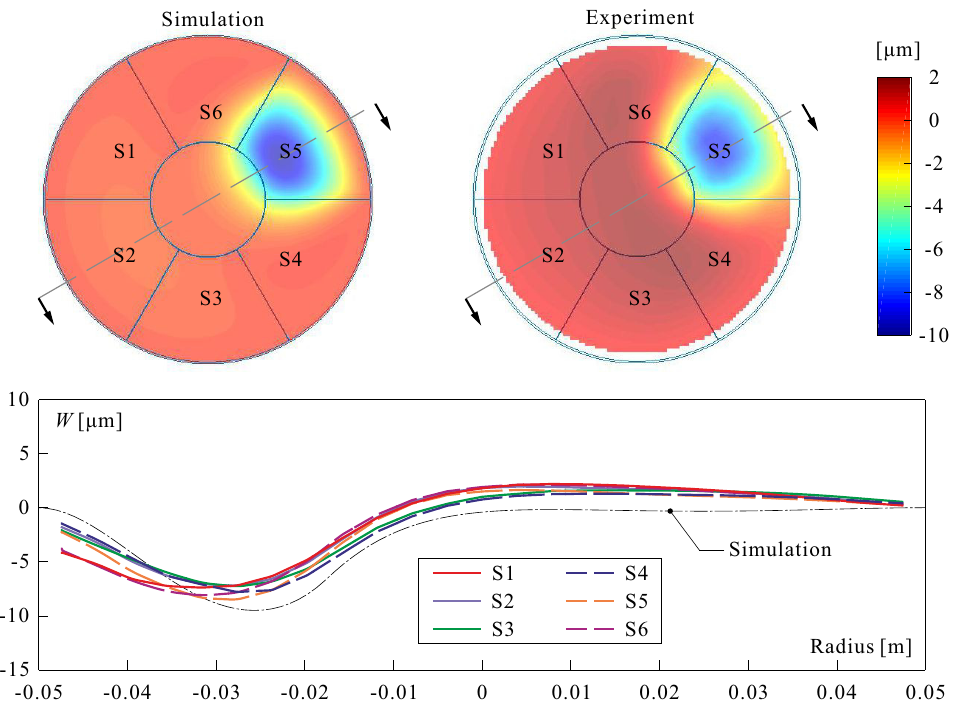
Figure 15. ( Top ): Comparison between experiment and simulation of the deformation induced by a voltage of 100 V being applied to electrode S 5 . ( Bottom ): Displacements along the 6 cross sections rotated by 60 ◦ The dashed line corresponds to the numerical